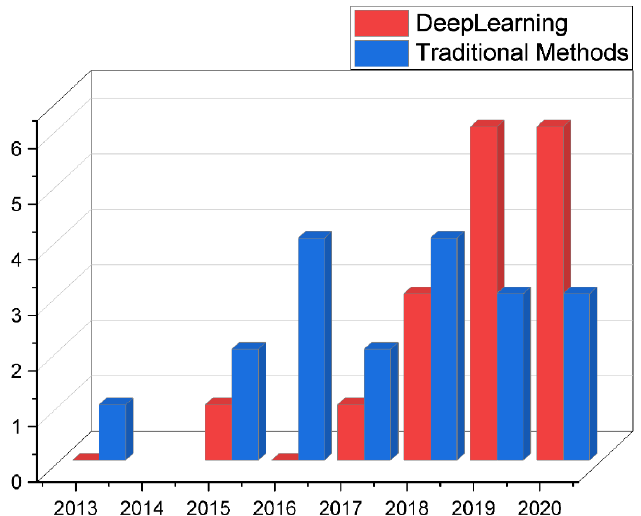
Figure 6. Development trend of traditional methods and deep learning methods in ship detection.